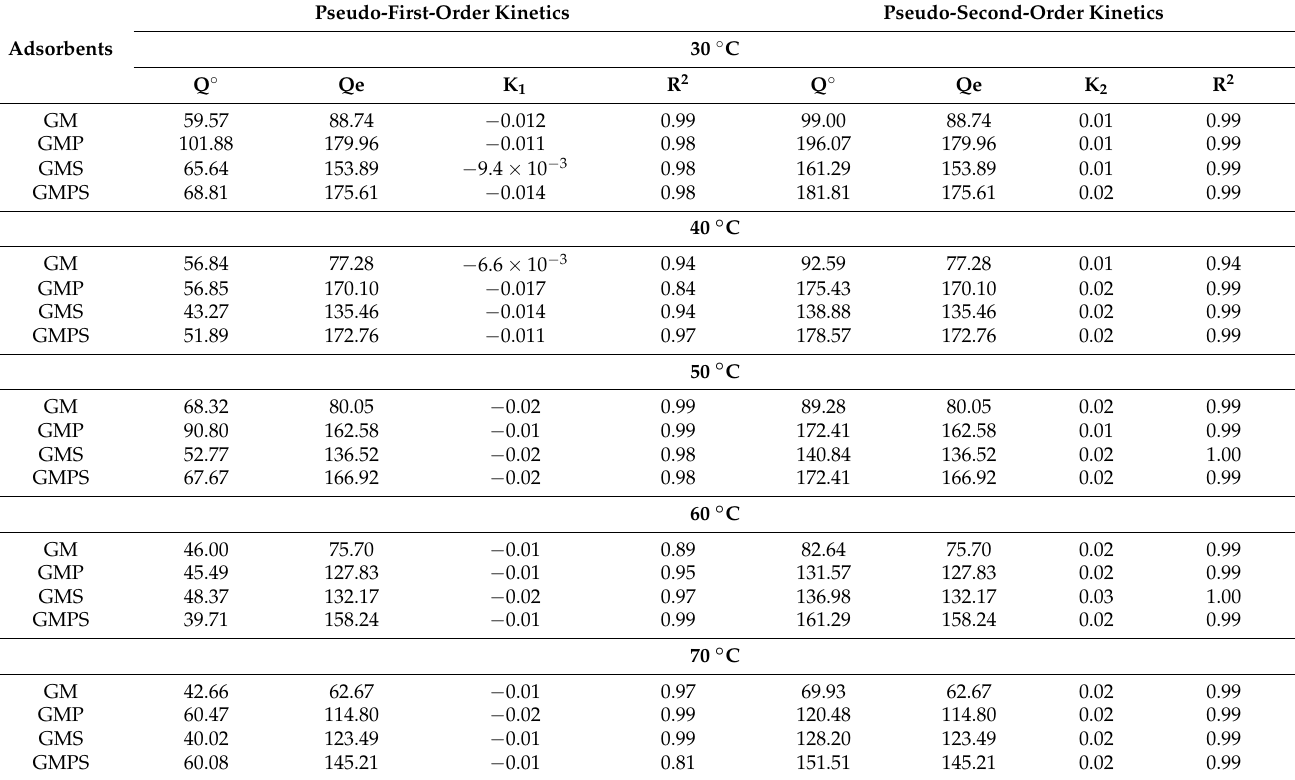
Table 4. Comparison of pseudo-first-order kinetics and pseudo-second-order kinetics for Foron black dye using golden marble waste composites at different